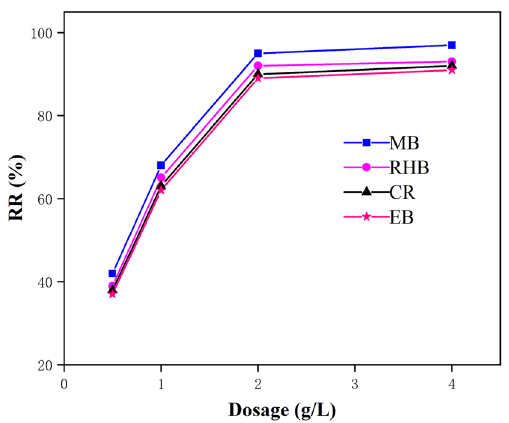
of MB, RHB, CR and EB e